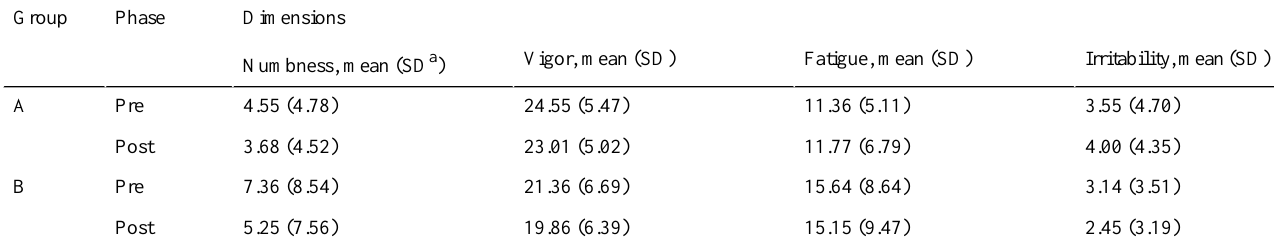
Table 6. Aggregated values for numbness, vigor, fatigue, and irritability for groups A and B (both n=22).